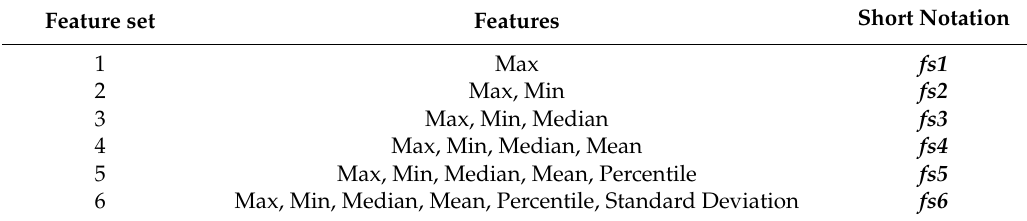
Table 3. Feature sets and their notations.